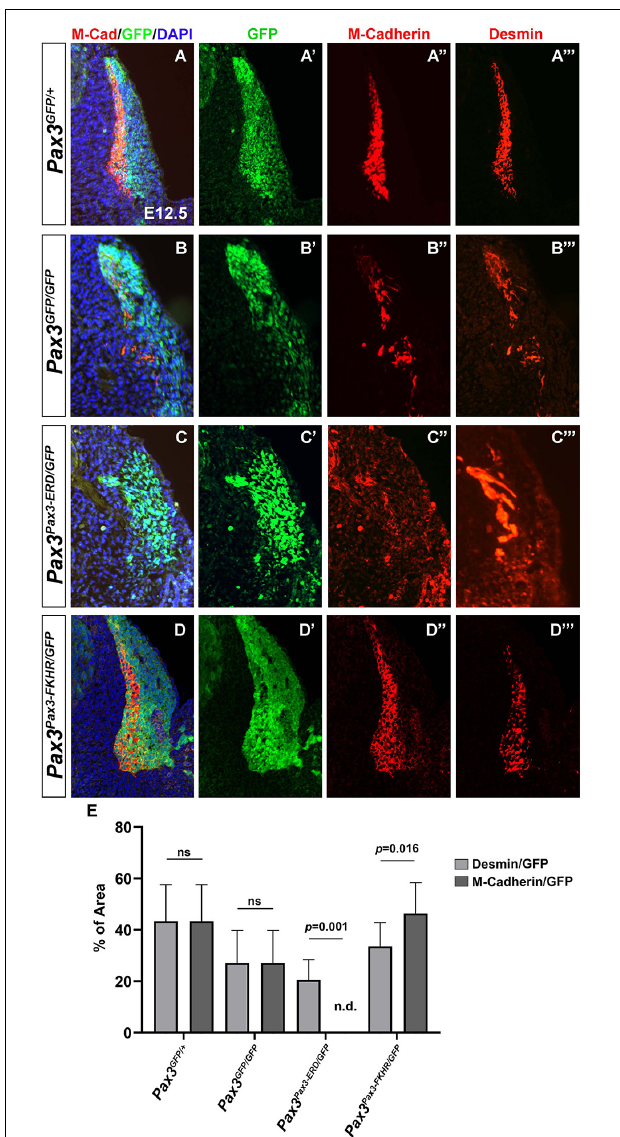
FIGURE 4 | Characterization of M-Cadherin expression in the myotome of embryos with different Pax3 alleles. (A–D) Immunostaining on transverse sections of E12.5 embryos to visualize M-Cadherin (red), GFP (green) that labels the PAX3 genetic lineage, Desmin (far-red and represented in red in the panels A (cid:48)(cid:48)(cid:48) ,B (cid:48)(cid:48)(cid:48) ,C (cid:48)(cid:48)(cid:48) ,D (cid:48)(cid:48)(cid:48) ) and DAPI to visualize the nuclei (blue) in control ( Pax3 GFP / + ) (A) , Pax3 -mutant ( Pax3 GFP / GFP ) (B) , Pax3 Pax 3 - ERD / GFP (C) , and Pax3 Pax 3 - FKHR / GFP (D) embryos. (A (cid:48) ,B (cid:48) ,C (cid:48) ,D (cid:48) ) Immunostaining to visualize GFP (green) that labels the PAX3 lineage (same section as in A–D ), in control ( Pax3 GFP / + ) (A (cid:48) ) , Pax3 -mutant ( Pax3 GFP / GFP ) (B (cid:48) ) , Pax3 Pax 3 - ERD / GFP (C (cid:48) ) , and Pax3 Pax 3 - FKHR / GFP (D (cid:48) ) embryos. (A (cid:48)(cid:48) ,B (cid:48)(cid:48) ,C (cid:48)(cid:48) ,D (cid:48)(cid:48) ) Immunostaining to visualize M-Cadherin (red) (same section as in A–D ) in control ( Pax3 GFP / + ) (A (cid:48)(cid:48) ) , Pax3 -mutant ( Pax3 GFP / GFP ) (B (cid:48)(cid:48) ) , Pax3 Pax 3 - ERD / GFP (C (cid:48)(cid:48) ) , and Pax3 Pax 3 - FKHR / GFP (D (cid:48)(cid:48) ) embryos. (A (cid:48)(cid:48)(cid:48) ,B (cid:48)(cid:48)(cid:48) ,C (cid:48)(cid:48)(cid:48) ,D (cid:48)(cid:48)(cid:48) ) Immunostaining to visualize Desmin (red) (same section as in A–D ) in control ( Pax3 GFP / + ) (A (cid:48)(cid:48)(cid:48) ) , Pax3 -mutant ( Pax3 GFP / GFP ) (B (cid:48)(cid:48)(cid:48) ) , Pax3 Pax 3 - ERD / GFP (C (cid:48)(cid:48)(cid:48) ) , and Pax3 Pax 3 - FKHR / GFP (D (cid:48)(cid:48)(cid:48) ) embryos. (E) Quantification of the percentage of the surface area of M-Cadherin vs. GFP and Desmin vs. GFP in the different Pax3 alleles. Graph represents the mean with standard deviations. The p -value was calculated with a two-tailed paired t